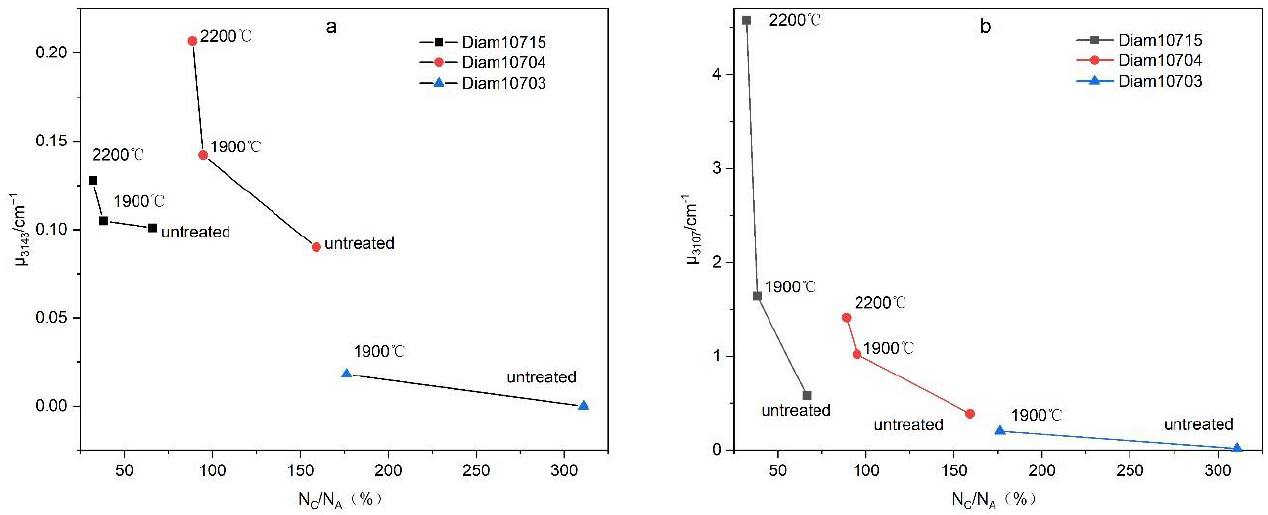
Figure 5. When the ratio of N C /N A is less than 1 (the left areas of the vertical dash line), the 3143 cm −1 absorption is more prominent. When the ratio of N C /N A is greater than 3, the 3143 cm −1 absorption coefficient is less than 0.05 cm −1 (below the horizontal dash line).